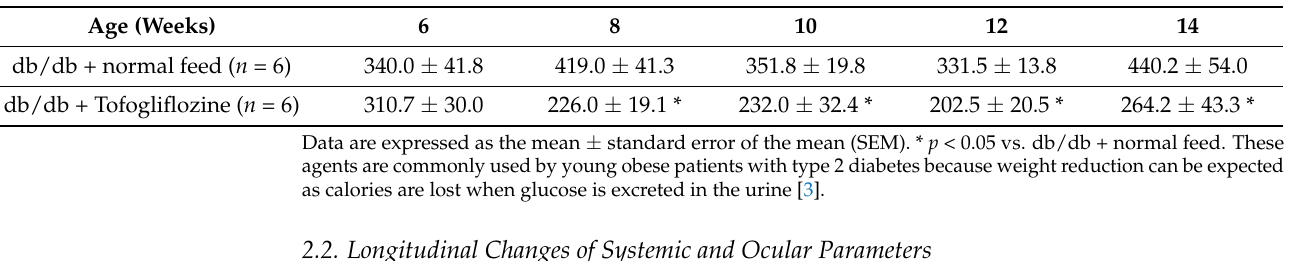
Table 1. Longitudinal changes in casual blood glucose